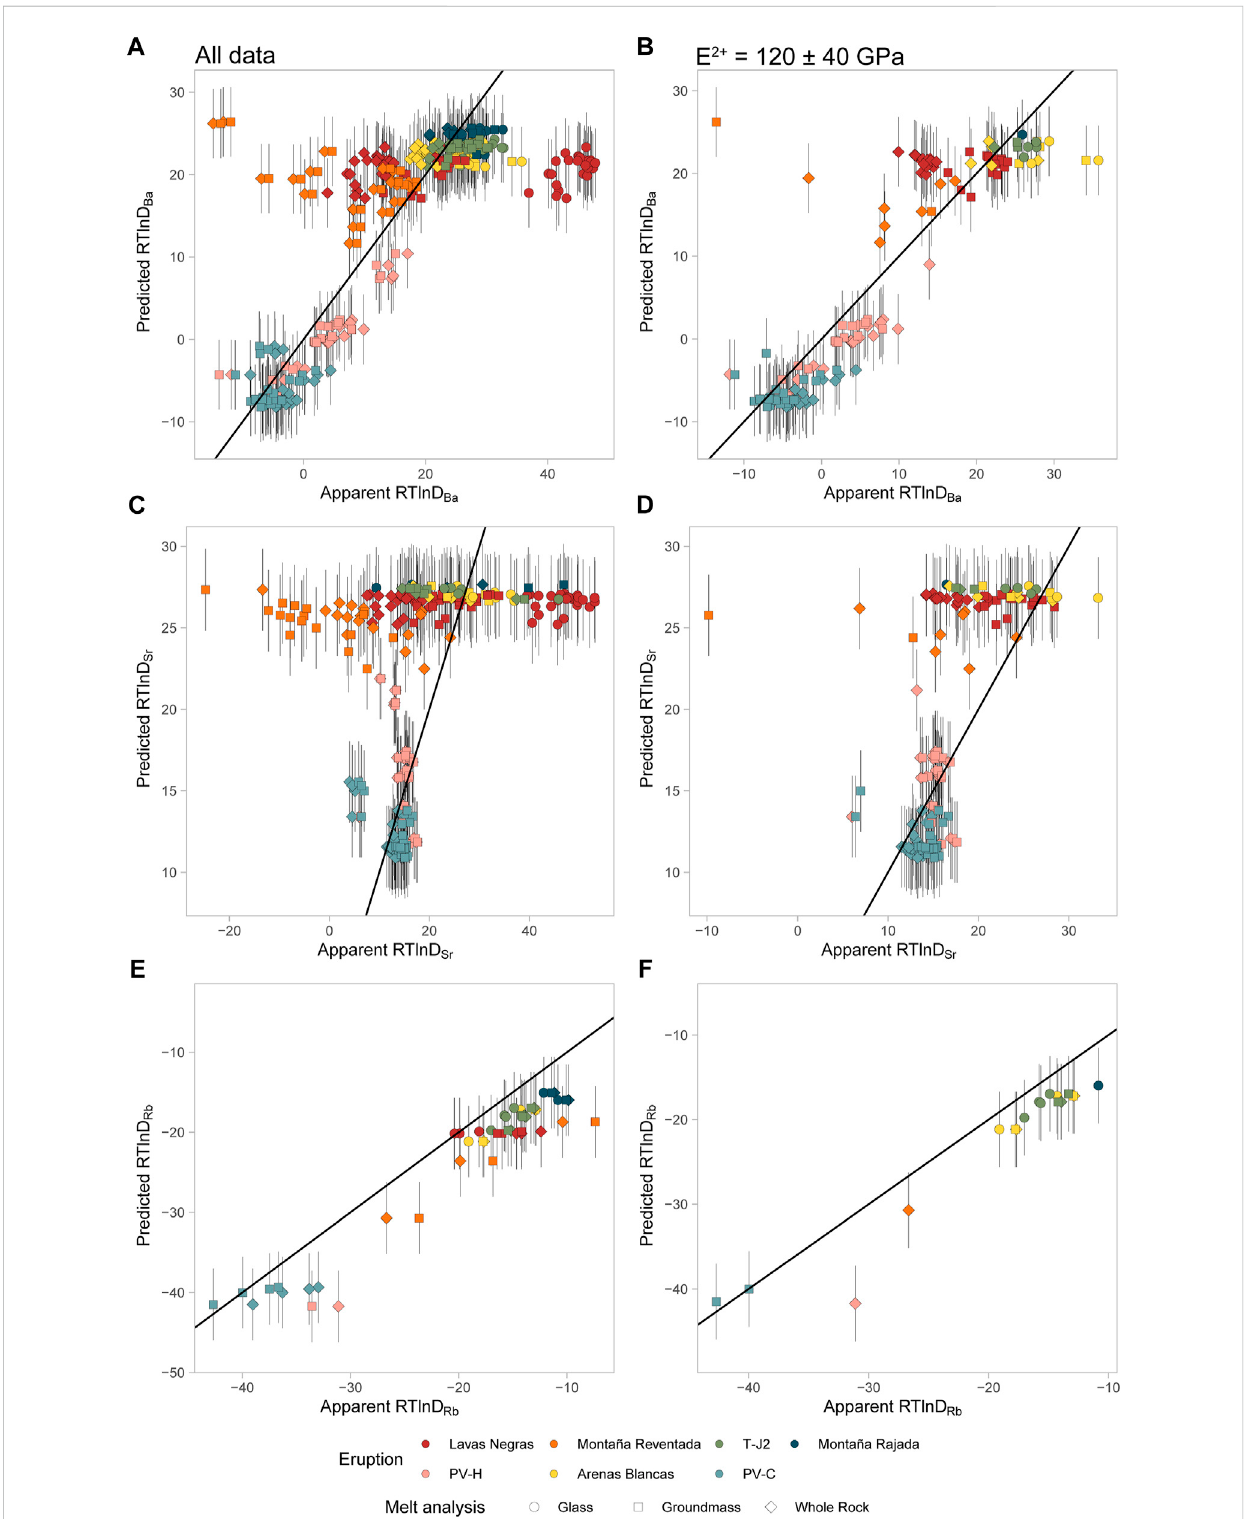
FIGURE 12 Diagrams showing RT ln D Ba , RT ln D Sr and RT ln D Rb predicted from Eqs 1 – 3, respectively, compared to observed values in T-PV samples. Thick black lines are the one-to-one correlation. Thin lines are error bars calculated by the model (±4.216 for RT ln D Ba , ±2.498 for RT ln D Sr and ±4.670 for RT ln D Rb ). (A) , (C) , (E) All D valuescalculatedinthiswork. (B) , (D) , (F) Onlymineral-meltpairswithan E 2+ valueintherangeof80 – 160 GPa.NotethatinsomecasesSr is below detection in EPMA analyses, and therefore is not represented in these